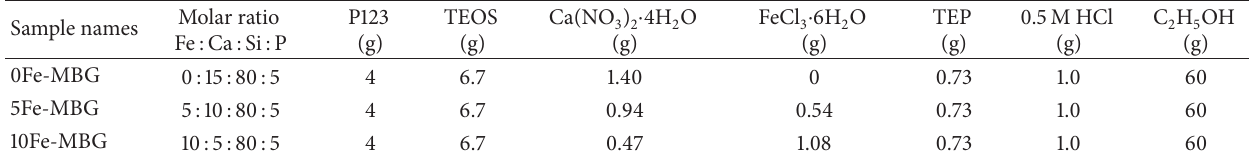
Table 1: Chemical composition and the amounts of the reagents of different MBG sol